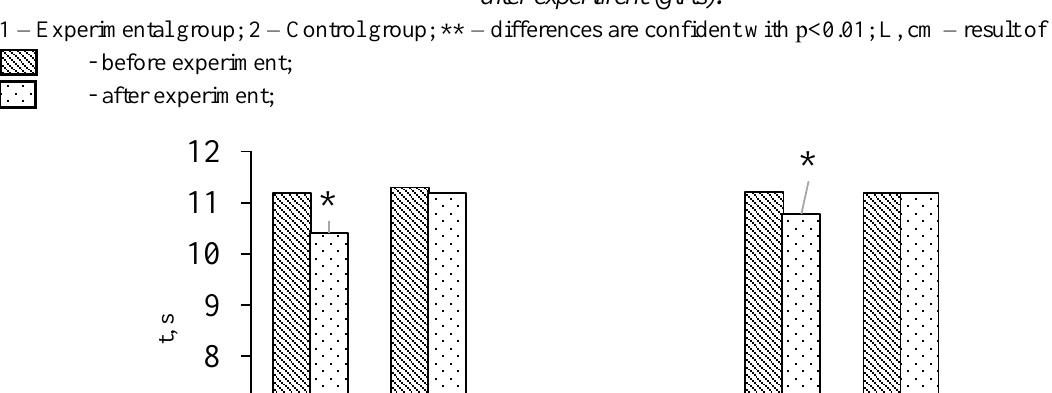
Fig.1. Results of test “Long jump from run” of experimental group pupils (n=21) and control group (n=22) before and after experiment (girls):